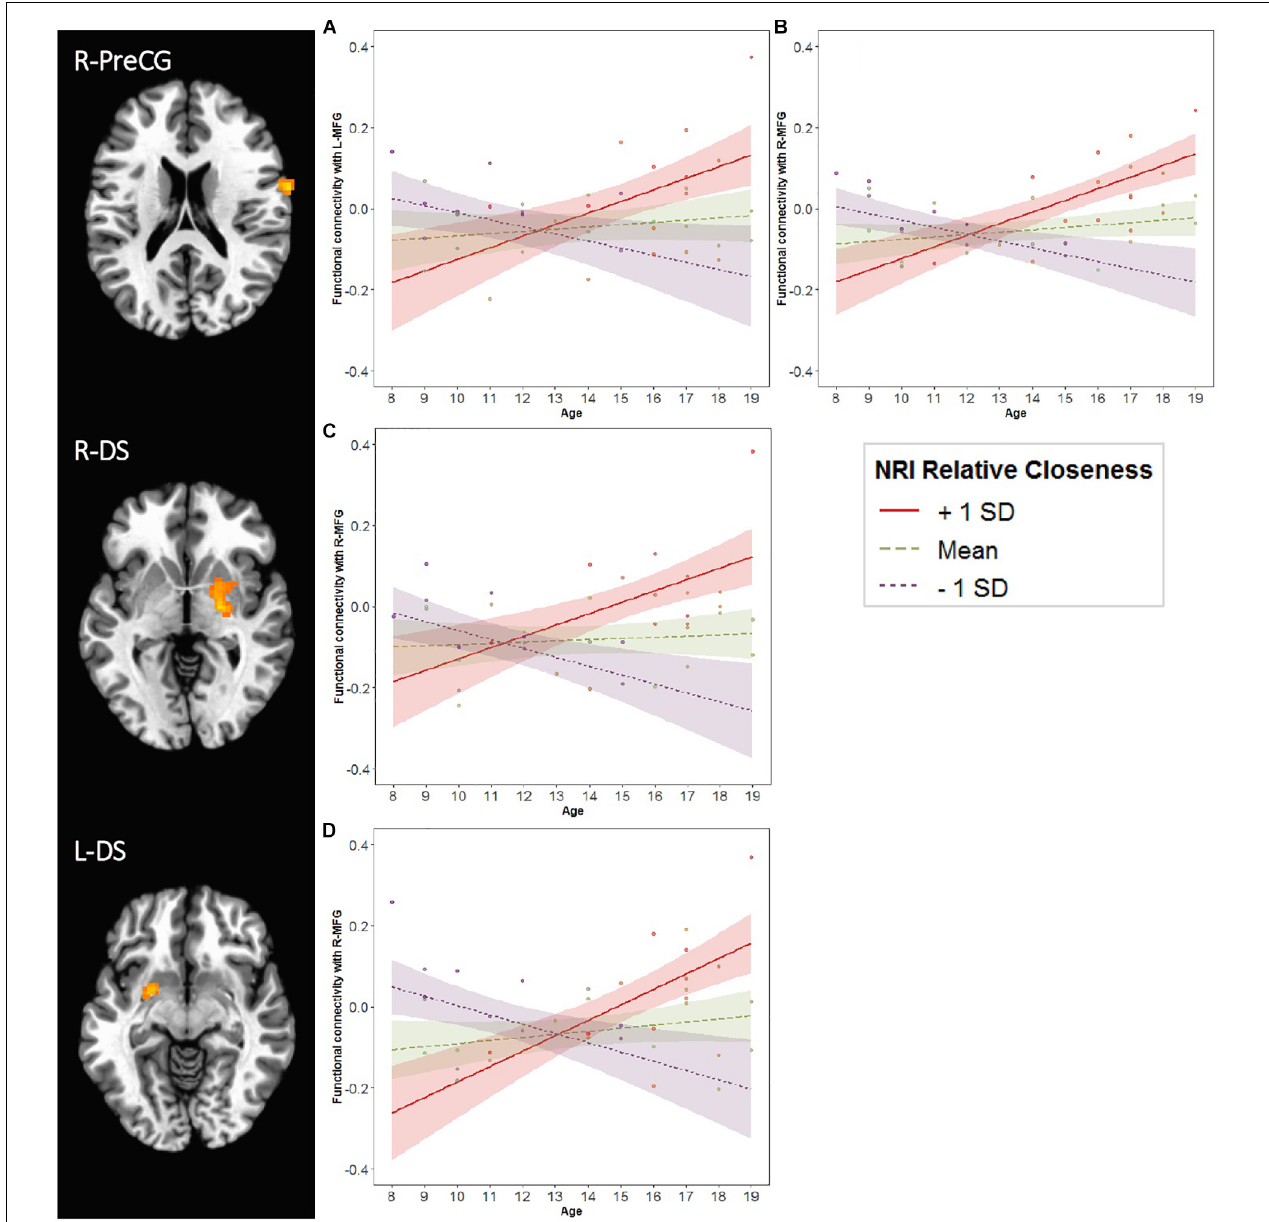
FIGURE 7 | Age and Relative Closeness-related changes in functional connectivity with left and right middle frontal gyrus (MFG). Generalized psychophysiological interactions were computed by placing a seed in each of the two MFG clusters (L-MFG and R-MFG; see Table 2 and Figure 4 ). Brain regions above represent areas for which there was an interaction of Age × Relative Closeness on functional connectivity with the seeds. Clusters were formed using 3dclustsim at p < 0.001, with a cluster size threshold of 27 voxels. Refer to Table 3 for description of regions of activation. Brain images are rendered in the Talairach-Tournoux template space. L, left; R, right. PreCG, precentral gyrus; DS, dorsal striatum. The line graphs illustrate the Age × Relative Closeness on functional connectivity between the R-PreCG and L-MFG (graph A ), the R-PreCG and R-MFG (graph B ), the R-DS and R-MFG (graph C ), and the L-DS and R-MFG (graph D ). SD, standard deviation; NRI, Network of Relationships